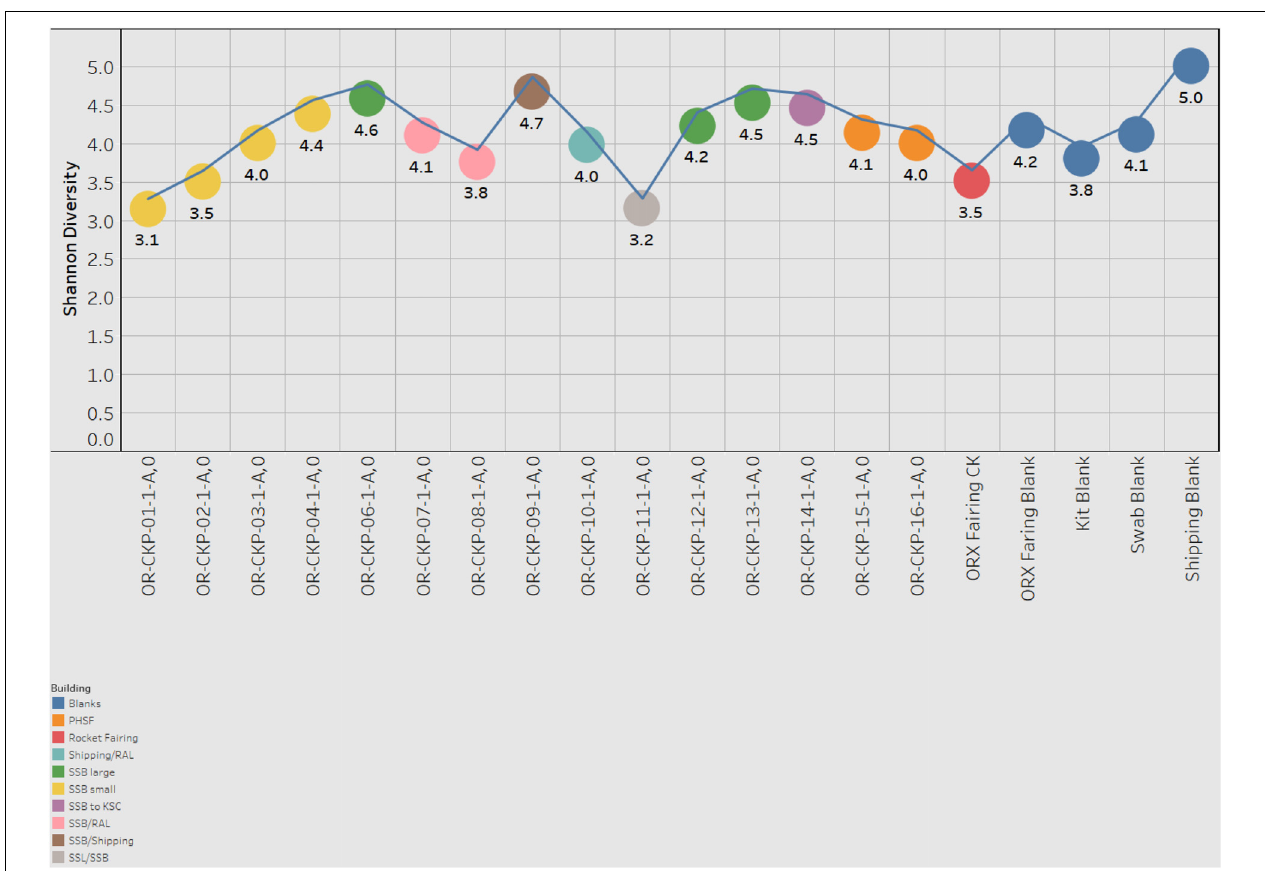
FIGURE 7 | Shannon index for each sample. Samples are colored according to the building in which the witness foil was exposed.